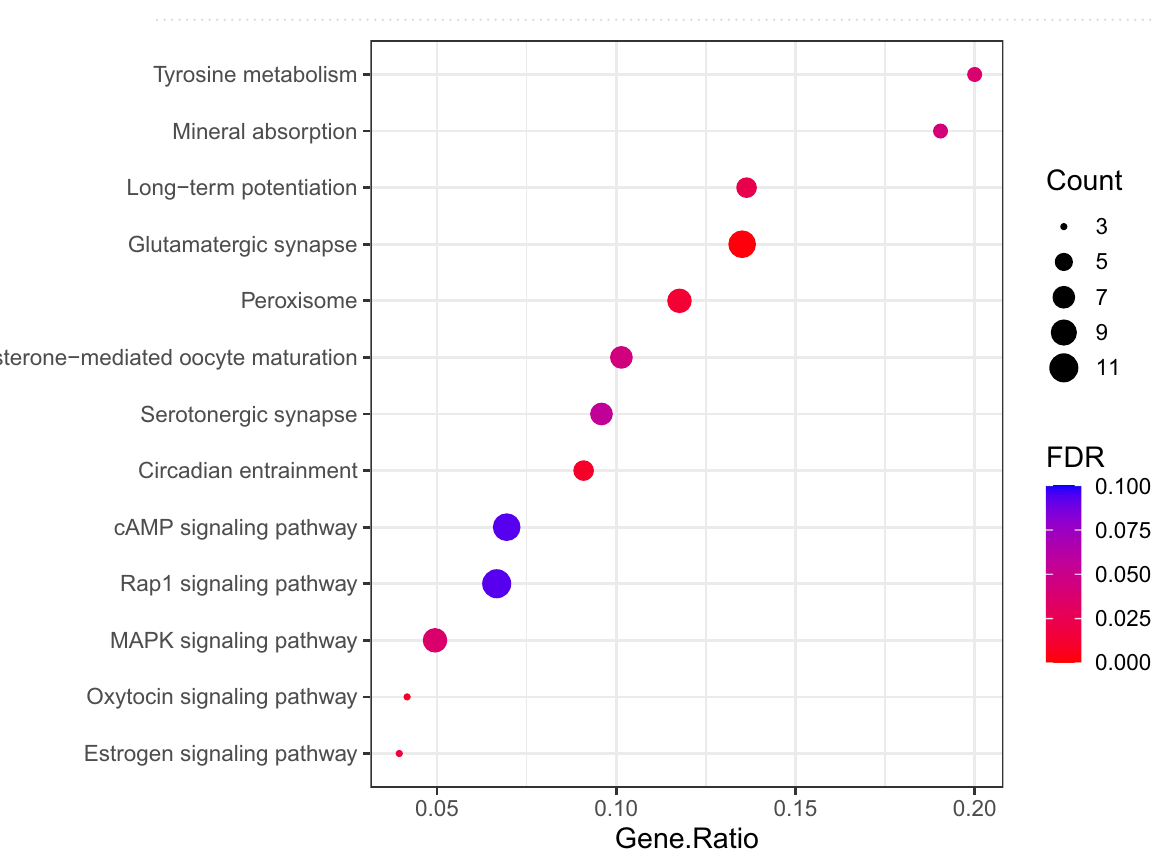
Figure 4. GO enrichment analysis, showing terms significantly enriched with the identified DEG’s between HEL and LEL ducks.